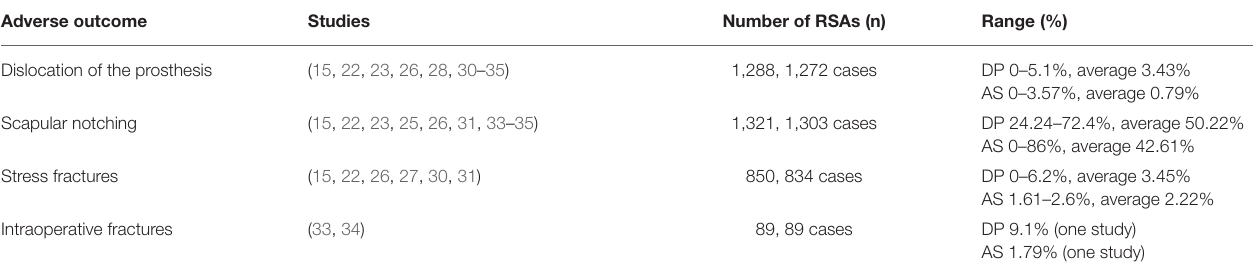
TABLE 3 | Main adverse outcomes following deltopectoral and anterosuperior approaches. Adverse outcome